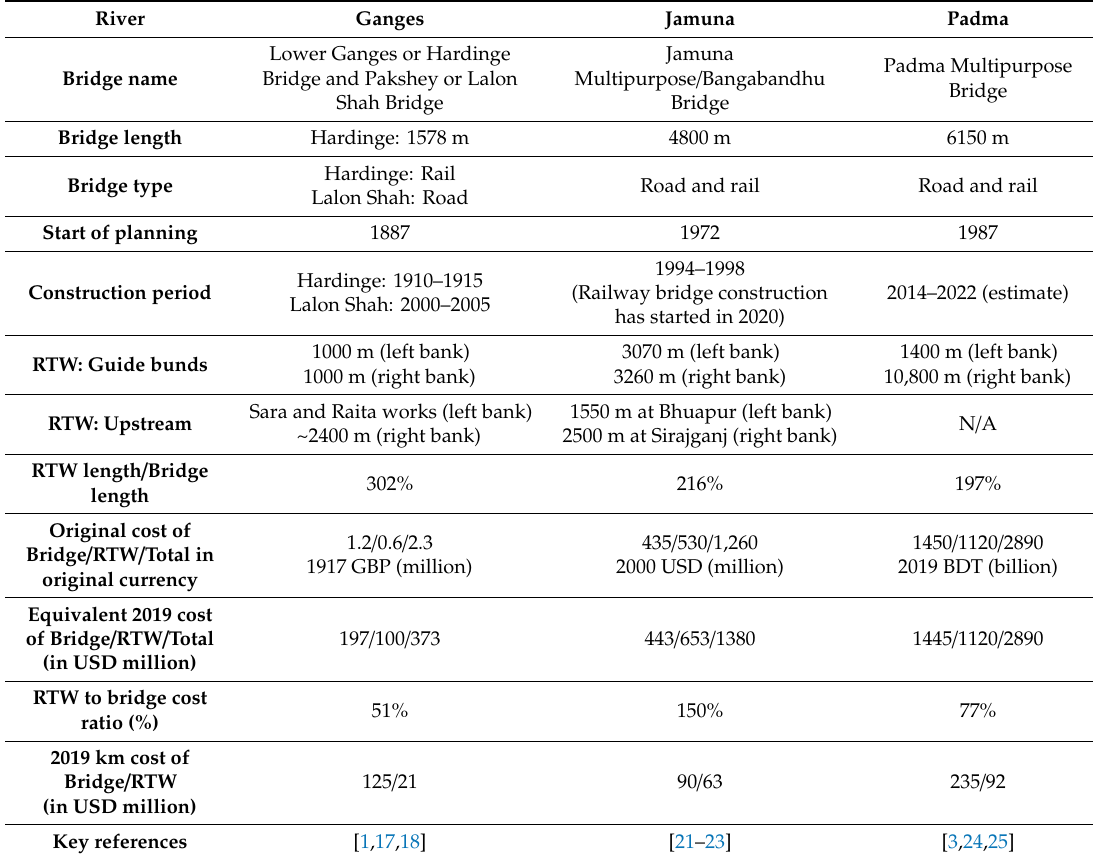
Table 1. Comparison of river training works in Bangladesh (RTW = river training works).